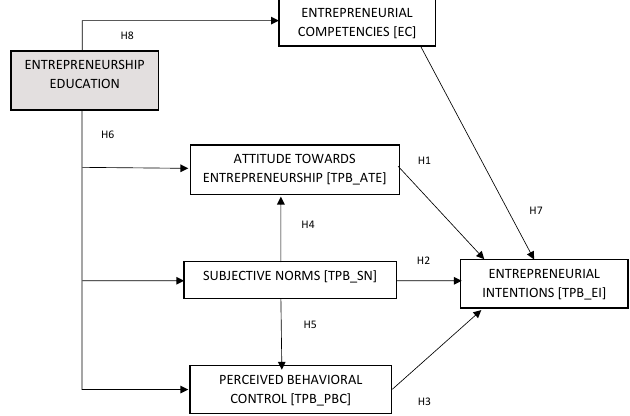
Fig. 1 – Conceptual research model to study the effects of EE on EC and EI. Source: own